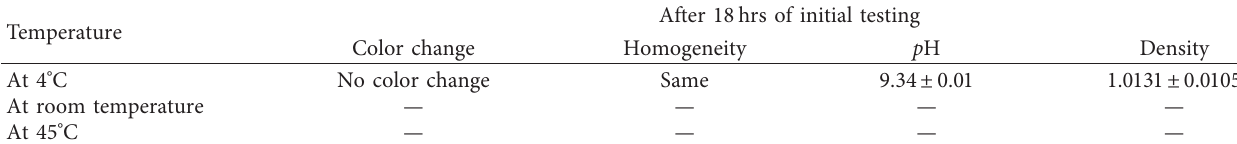
Table 11: Stability study of